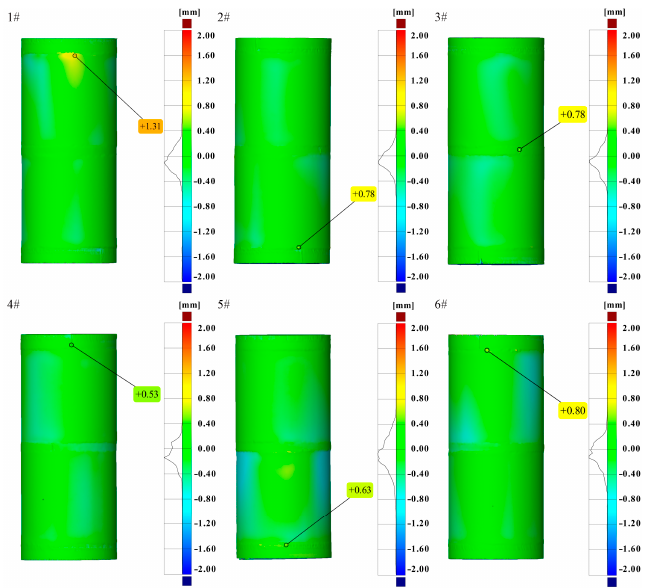
Figure 4. Shape deviations from the perfect geometry for six fabricated bi-segment cylindrical preforms.